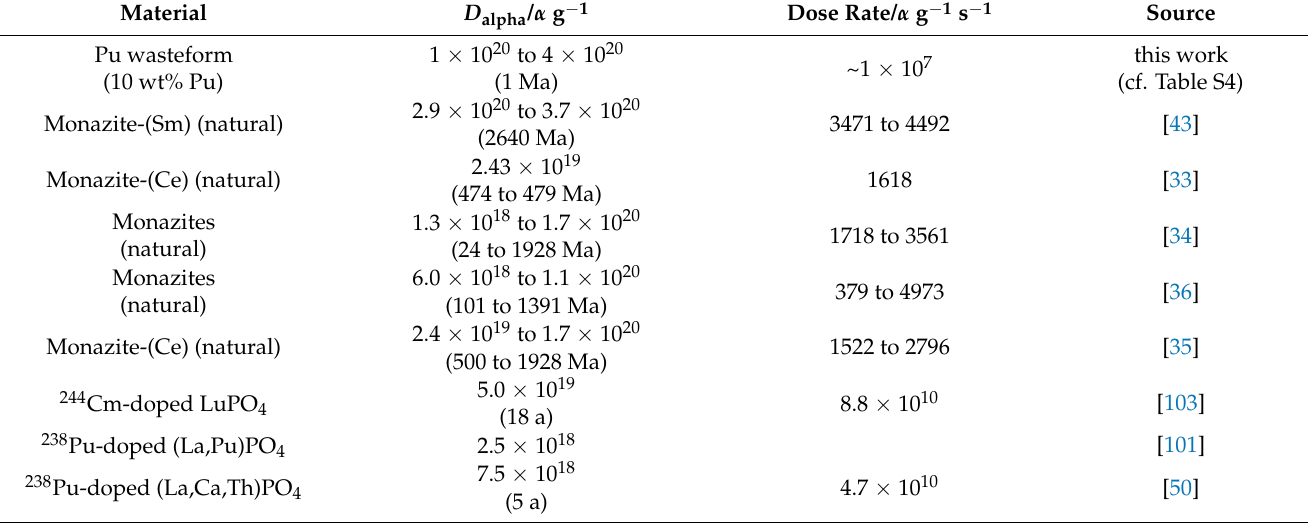
Table 7. Comparison of alpha doses ( D alpha ) and alpha dose rates incurred in Pu waste forms (10 wt% Pu loading) in 10 6 years to nonmetamict monazites from nature and alpha-doped Ln -phosphates with monazite structure (in parentheses: exposure time ( Ln PO 4 ) or age (monazites),